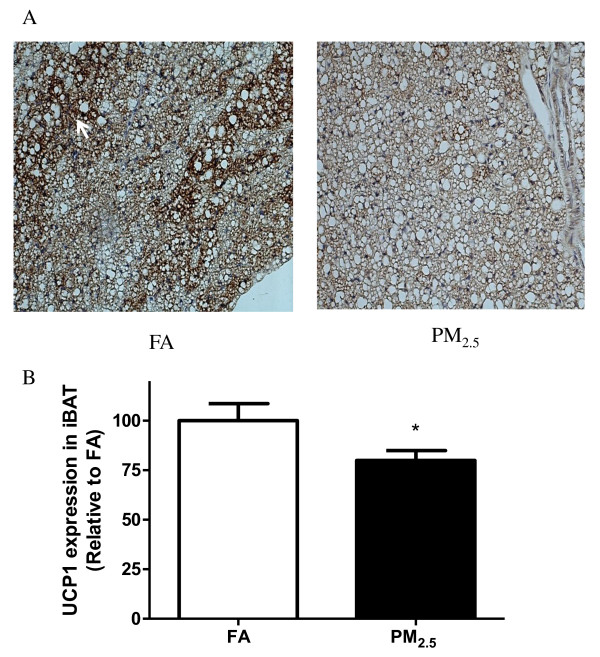
Immunohistochemical examination of uncoupling protein 1 (UCP1) in the iBAT. A. iBAT was stained by antibody against UCP1 and counterstained with hematoxylin. B. Quantification of UCP1 in iBAT. n = 8 *P < 0.05 vs. FA. Arrows show UCP1-positive brown adipocyte staining.